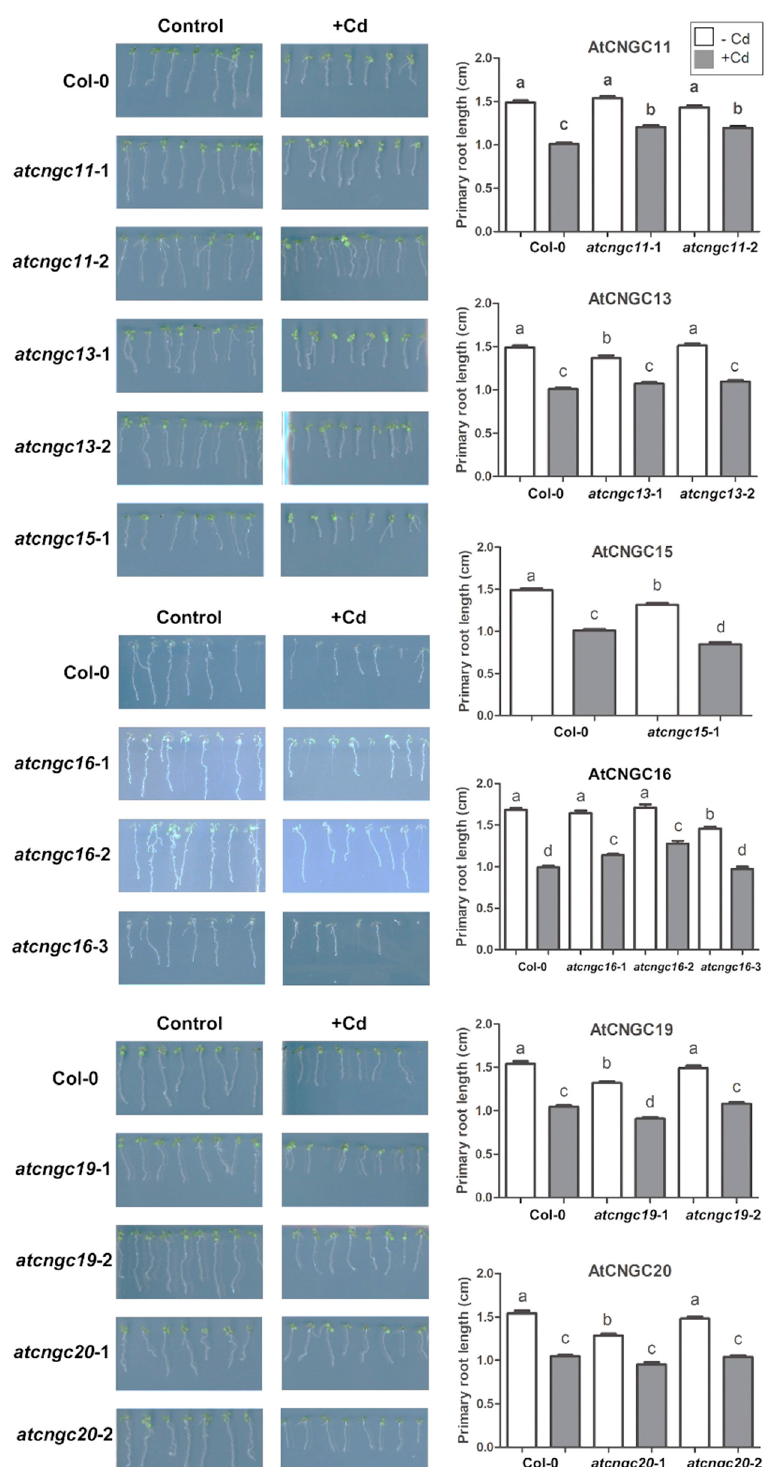
Figure 3. Growth of wild-type Arabidopsis and atcngc mutants in response to Cd 2+ . Eight-day-old seedlings grown on agar media supplemented with 55 µ M CdCl 2 were photographed and used to measure primary root growth (length) using ImageJ software. The presented images (left side of figure) are representatives of ≥ 80 seedlings of each genotype (the mutant or the wild-type) used to measure each treatment (right side of figure). Quantitative data presented represent the mean ± SEM. Data were subjected to a one-way ANOVA with a post-hoc Tukey’s comparison. Different letters indicate significant differences (p < 0.05).